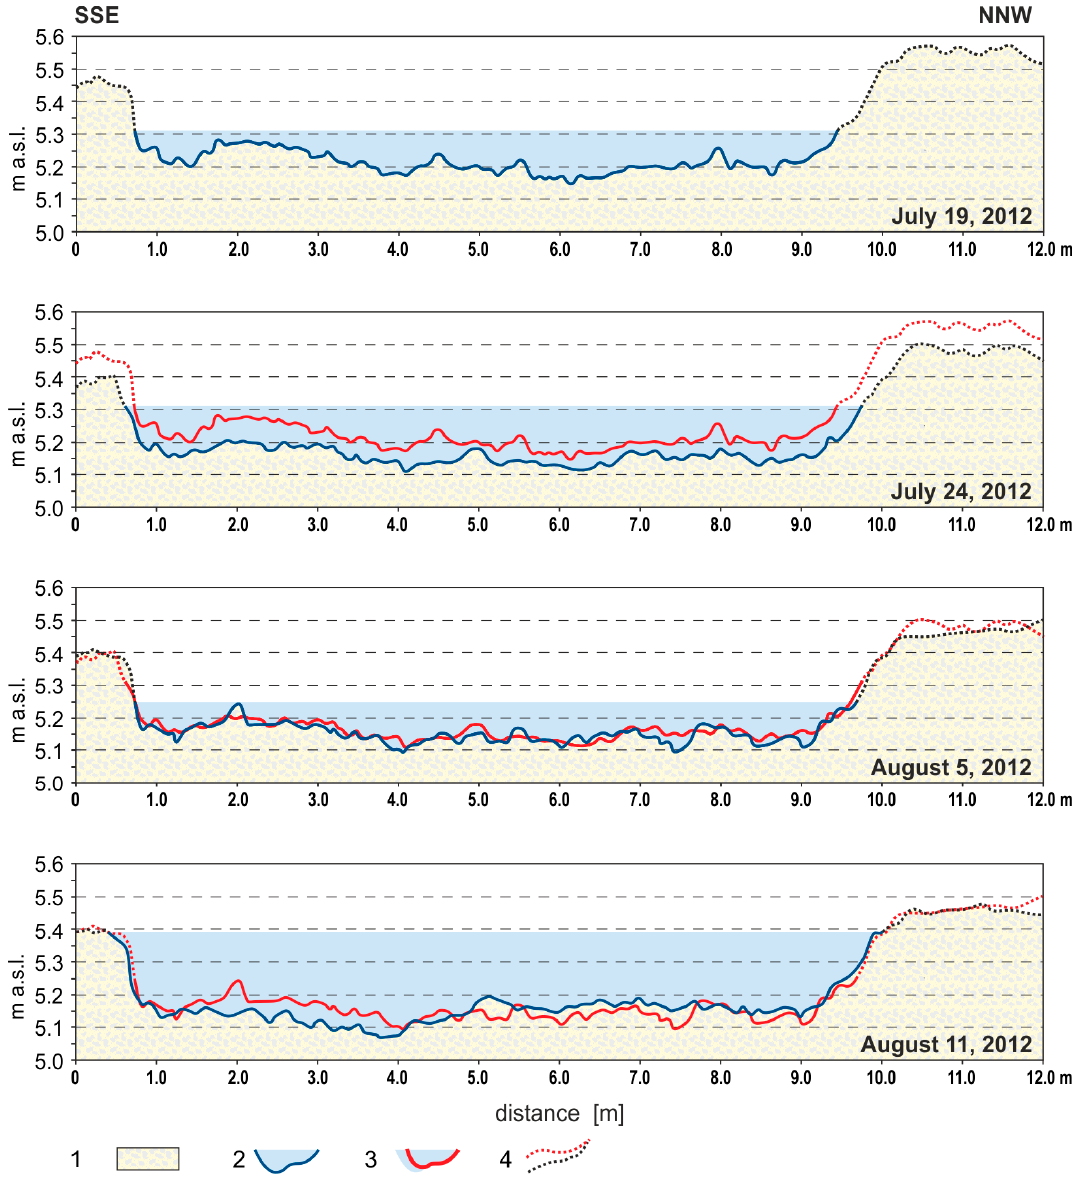
Figure 5. Changes in the channel bottom in XS I in 2012: 1. Bedrock, 2. Current stage, 3. Previous stage, 4. Dry streambank.